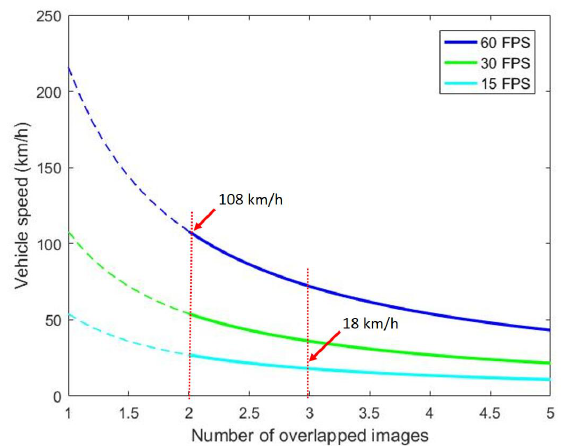
Figure 2. The number of images overlapped on each road surface at various vehicle speed.